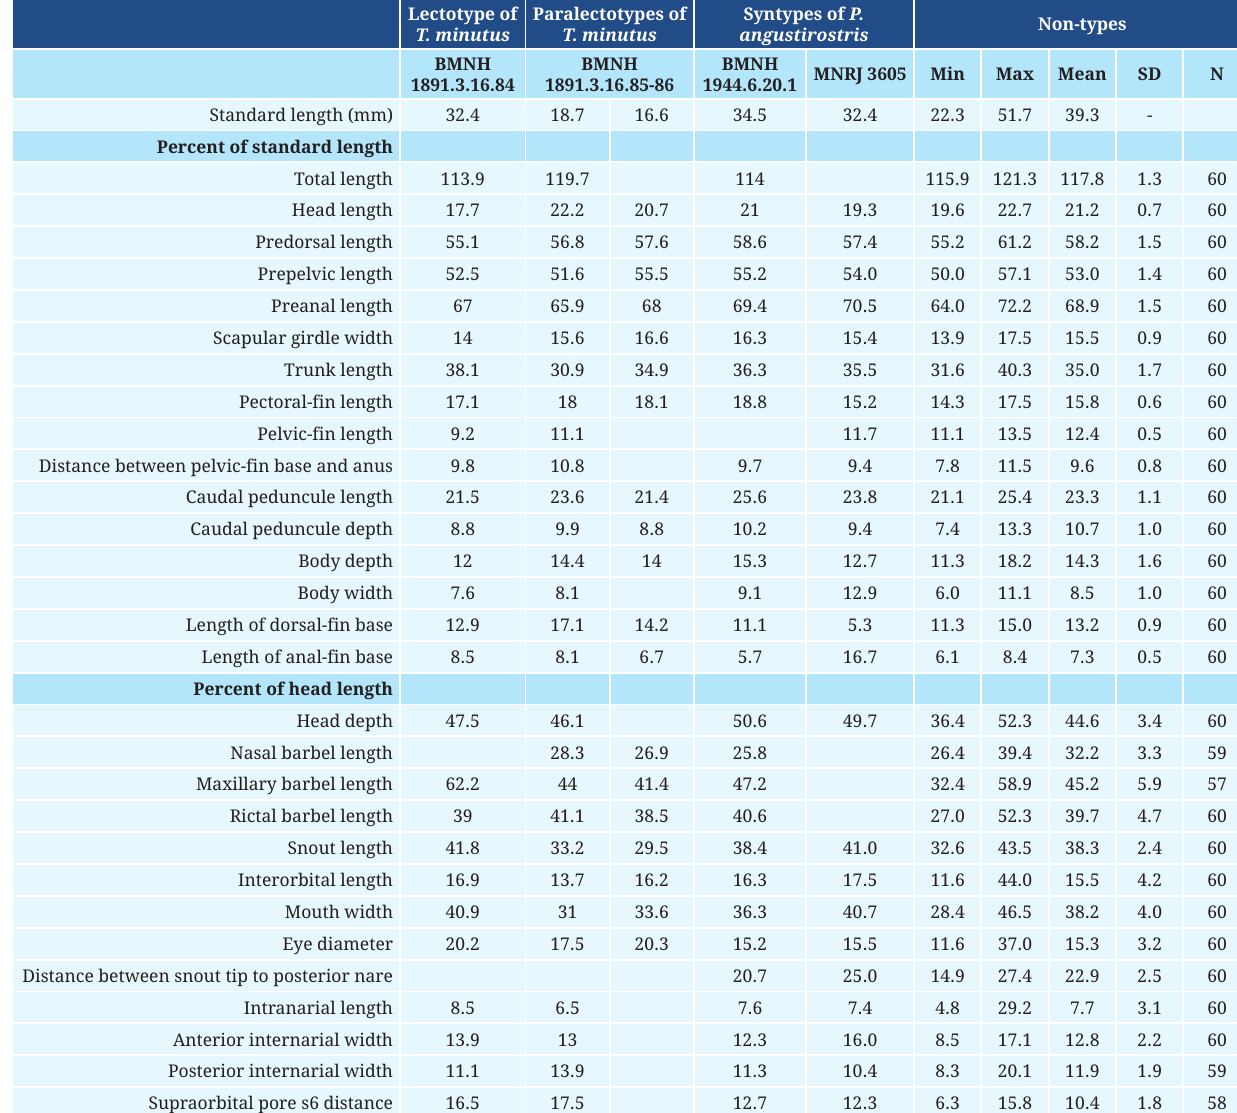
TABLE 8 | Morphometric data of Scleronema minutum (data of type specimens not included in the range of non-types). N = number of non- types; SD = standard